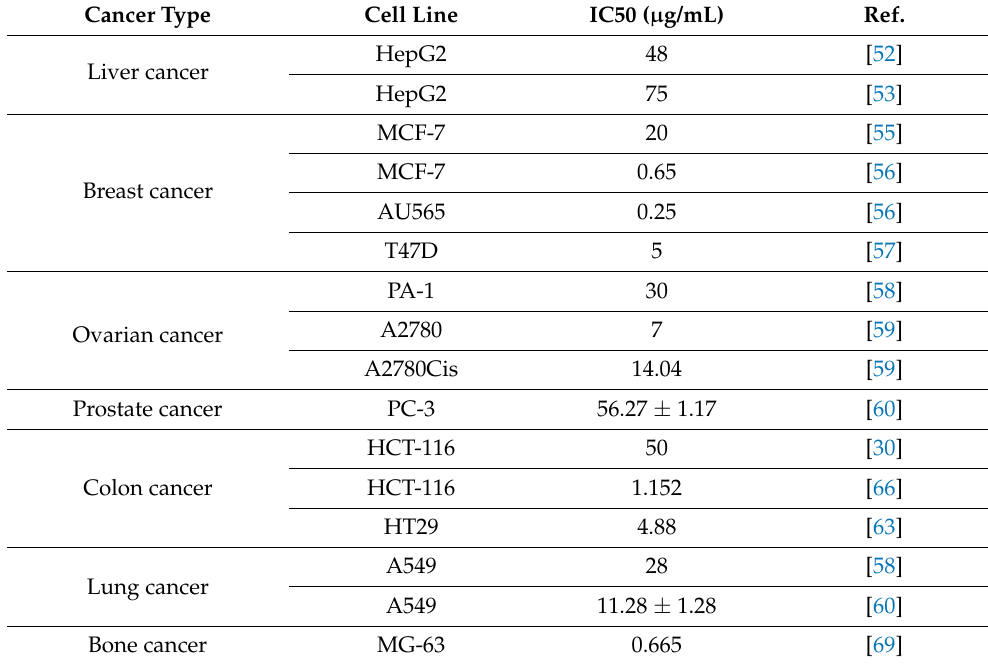
Table 1. Half-maximal inhibitory concentrations (IC50) of Ag NPs against various human cancer cell